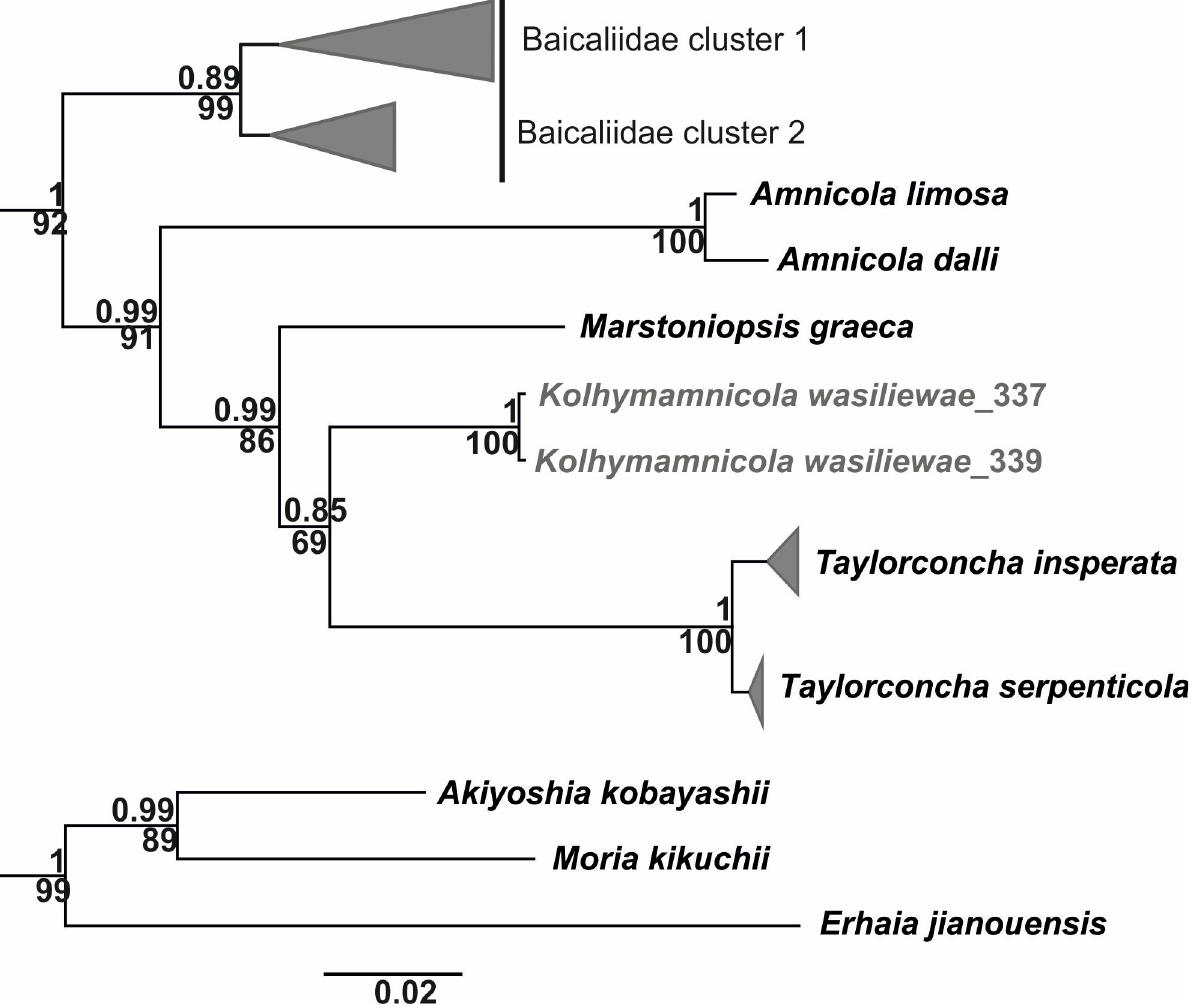
Figure 8. ML phylogenetic tree based on nucleotide sequences of COI, 16S, and 18S gene fragments. SH-aLRT supports are given above branches; bootstrap supports are given below branches.